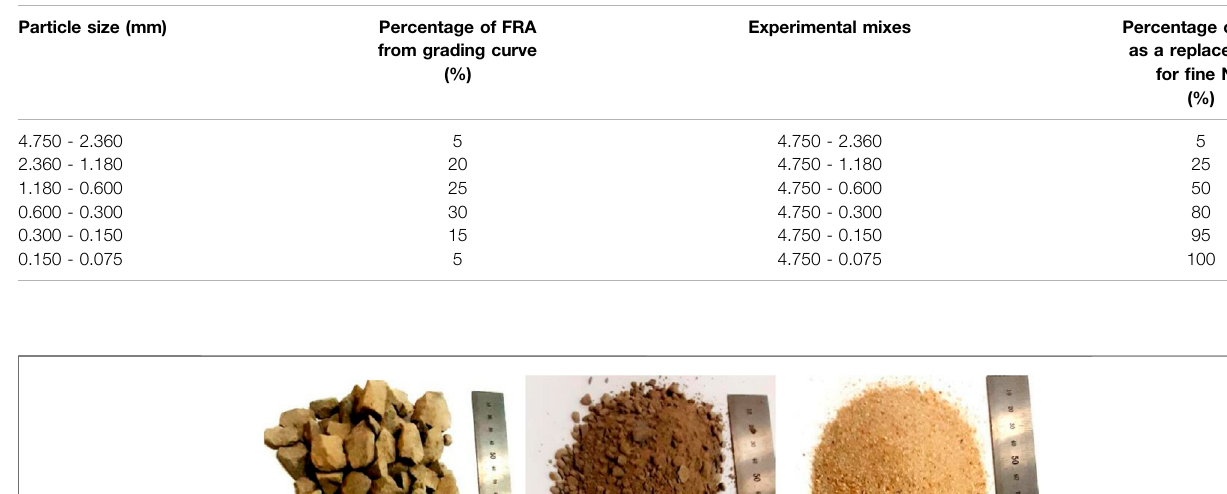
TABLE 1 | Systematic substitution of different FRA sizes in a mortar (Li et al., 2019).